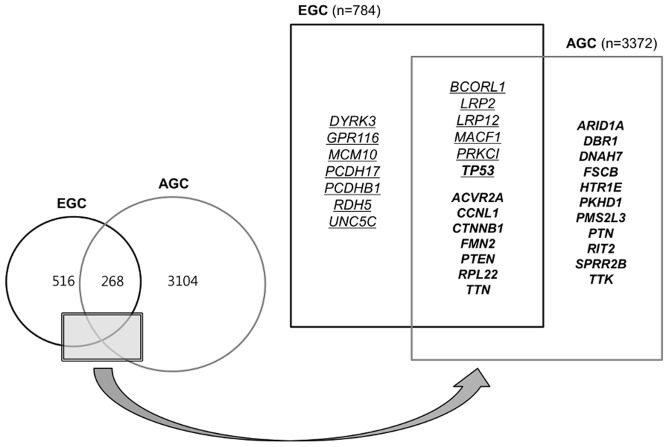
Venn diagram and schematic representation of all genes with non-silent mutations in gastric cancers.Underlined and bold font indicates the genes with protein-altering mutations in at least two early cancer samples and the selected genes with higher-than-expected mutation rates in advanced gastric cancers (false discovery rate<0.2), respectively.